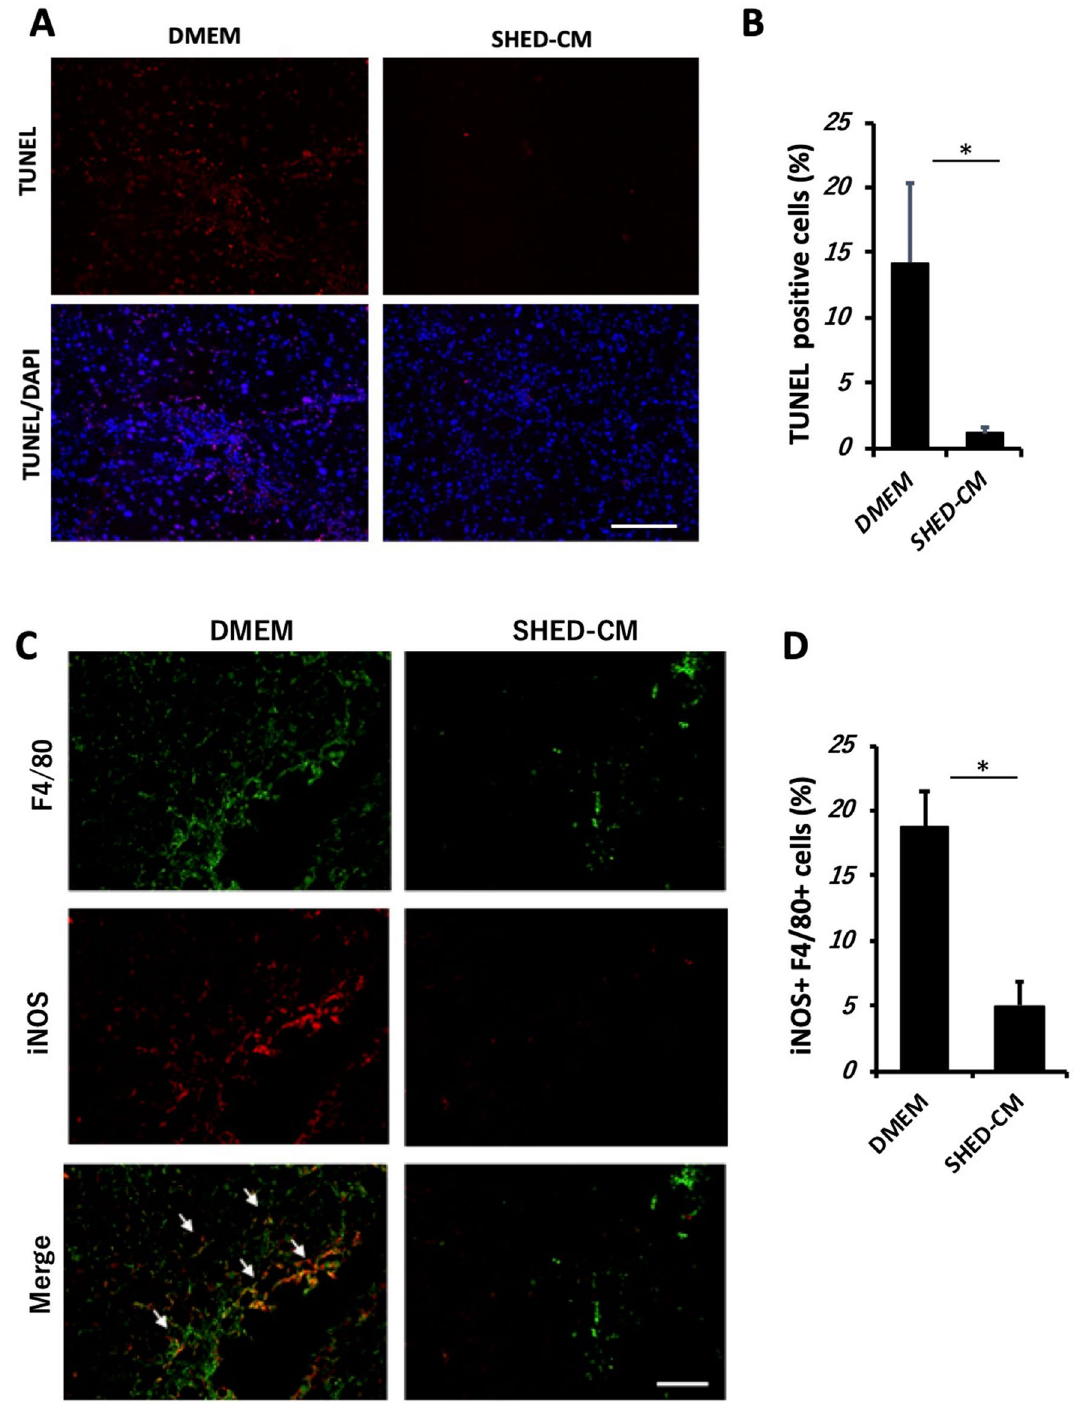
Figure 4. SHED-CM inhibits apoptosis of hepatic parenchymal cells and inflammatory macrophage activation. ( A ) Representative images of TUNEL analysis of liver sections. Scale bar = 200 μm. ( B ) Quantification of TUNEL + / DAPI-stained cells. Data represent mean ± SEM. * P < .05. n = 4, DMEM group; n = 5, SHED-CM group. ( C ) Representative images of immunohistologically stained hepatic macrophages. White arrows indicate that hepatic macrophages express both F4/80 and iNOS. Scale bar = 200 μm. ( D ) Quantification of iNOS + F4/80 + cells (%). Data represent mean ± SEM. * P < .05. n = 4 per group. Abbreviations: DMEM, Dulbecco’s modified Eagle’s medium; SHED-CM, serum-free conditioned medium from stem cells derived from human exfoliated deciduous teeth; TUNEL, terminal deoxynucleotidyl transferase 2’ ‐ deoxyuridine 5’ ‐ triphosphate nick ‐ end labeling; DAPI, 4’,6 ‐ diamidino ‐ 2 ‐ phenylindole; iNOS, inducible nitric oxide